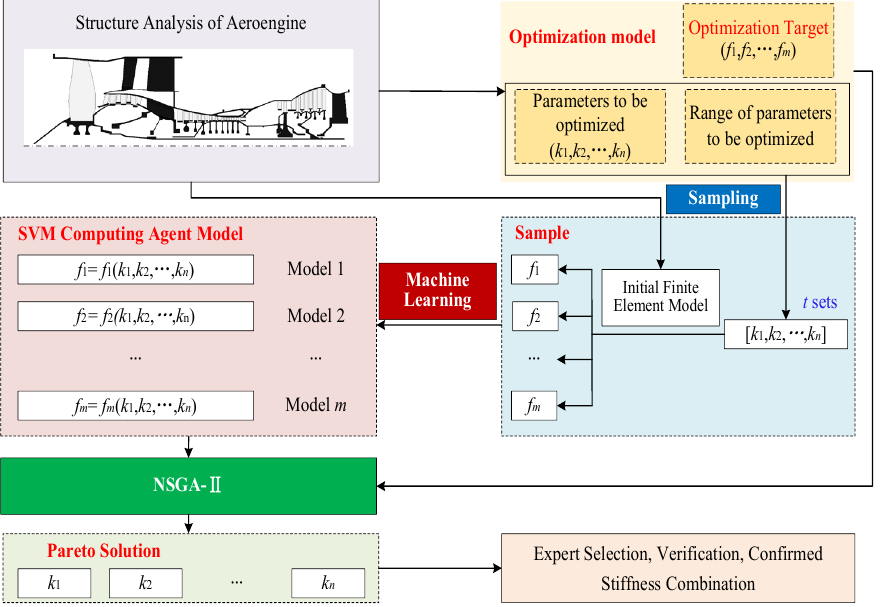
Figure 1. Flowchart of development process for multi-objective optimization design method for aeroengine coupling vibration.